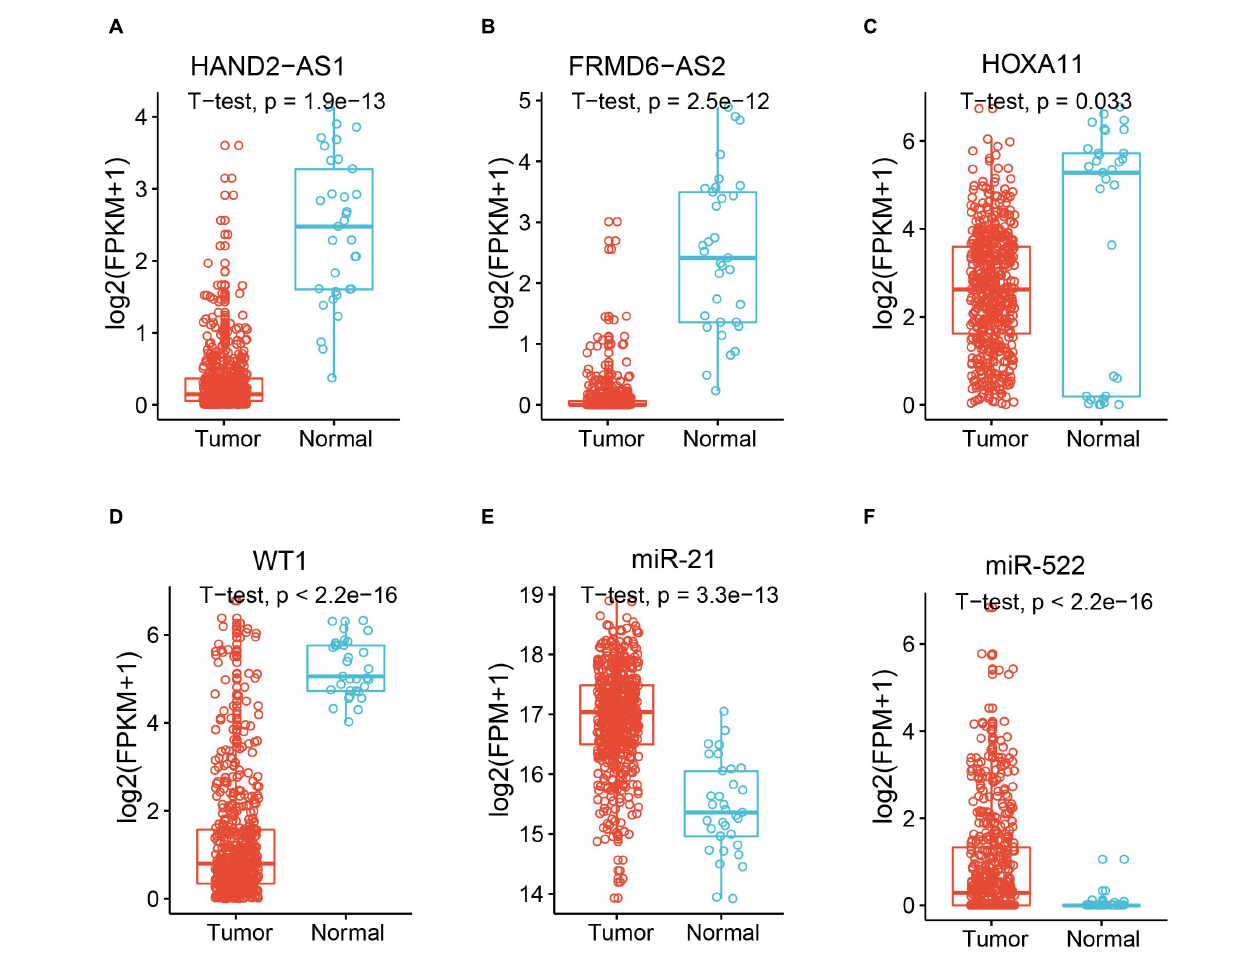
FIGURE 2 | Expression of example molecules in UCEC and the normal samples. The comparison of gene expression between tumor sample and the normal sample for differentially expressed lncRNAs HAND2-AS1 (A) and FRMD6-AS2 (B) , differentially expressed genes HOXA11 (C) and WT1 (D) , and differentially expressed miRNAs miR-21 (E) and miR-522 (F)